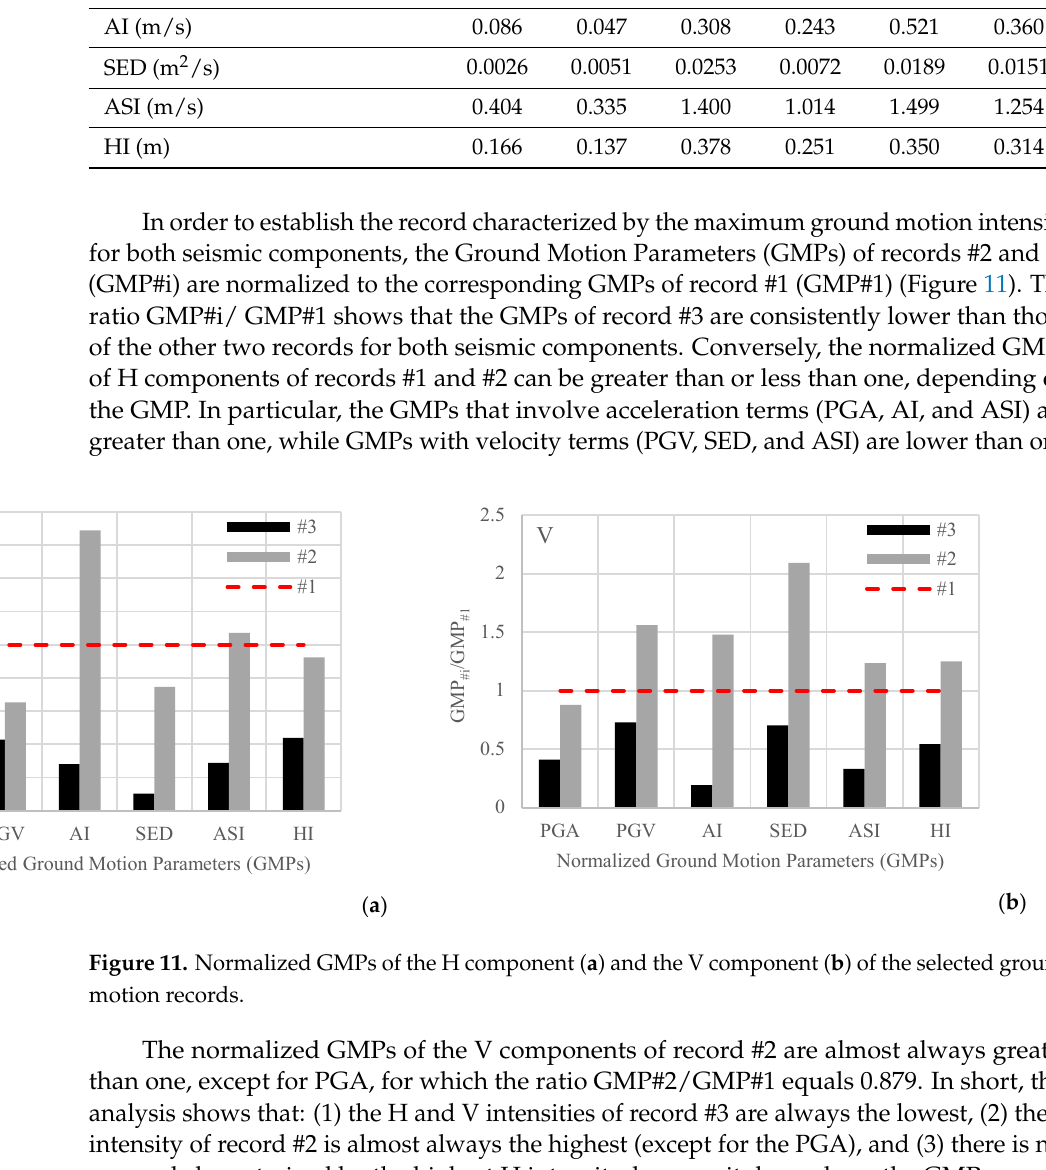
Table 5. Ground motion parameters of the H and V components of #1, #2, and #3 ground motion records.